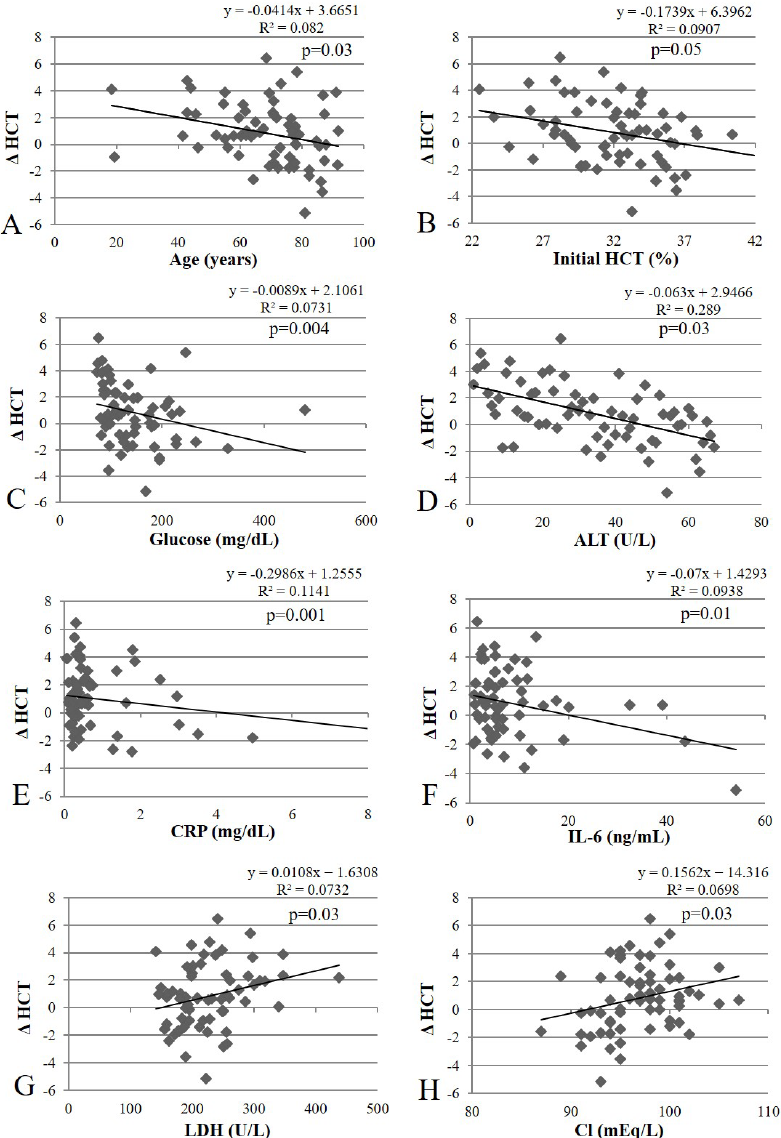
Figure 2. Linear regression analyses of significant factors associated with the erythropoietic re- sponse. Abbreviations: HCT, hematocrit; ALT, alanine aminotransferase; CRP, c-reactive protein; IL-6, interleukin-6; LDH, lactate dehydrogenase; Cl, chloride; ∆ HCT, change in HCT level from phase 1 to phase 3.